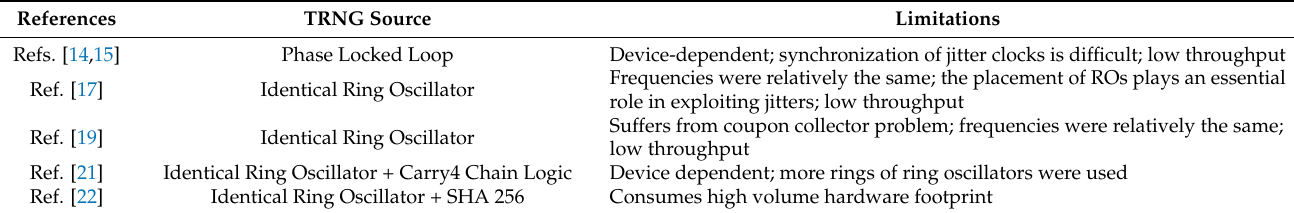
Table 1. TRNGs and its limitations.